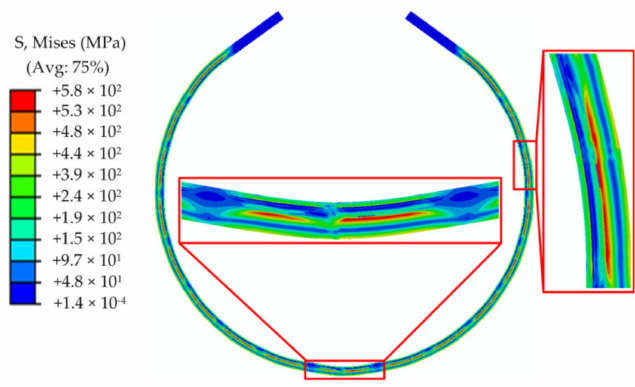
Figure 20. The Mises stress contour of results of the 2D model.